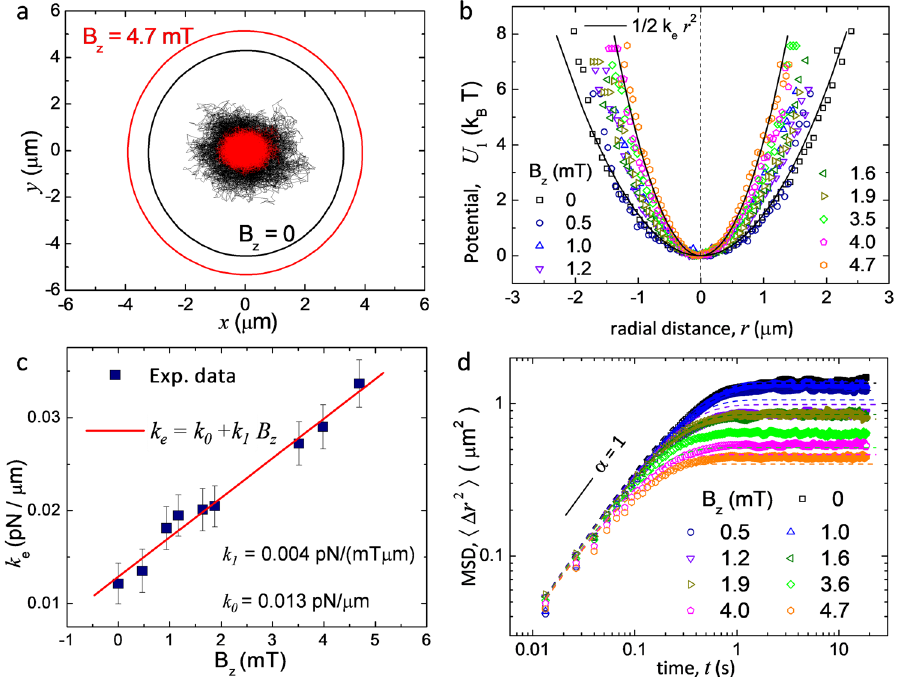
Fig. 2 Single-particle dynamics. a Two trajectories of one paramagnetic nanoparticle trapped above a magnetic bubble for B z = 0 mT (black line) and B z = 4.7 mT (red line), the circles indicate the corresponding locations of the Bloch wall. b Magnetic potential U for different values of the applied fi eld B z . Scattered points are experimental data, continuous lines are fi t using a simple harmonic approximation, U r ) = k r 2 /2. c Spring constant k 1 ( e e of the potential measured for different magnetic = 0.0129 ± 0.0012 pN/ μ m and k = 0.0043± 0.0005pN/(mT μ m). The error bars in the data result from the statistical average of different k 0 1 measurments. d Log – log plot of the mean-square displacement (MSD) for different applied magnetic fi elds. Continuous lines are fi ts obtained by using the theoretical model, see Eq. (2) and